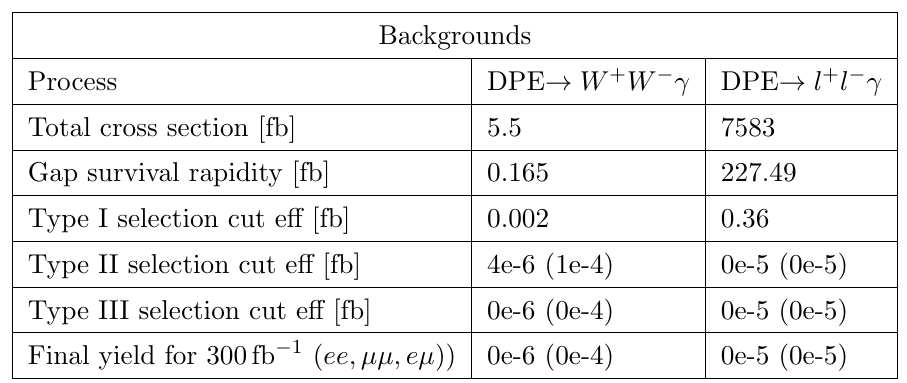
Table 4 . The sequence of di(cid:11)erent type of cuts on the cross sections of DPE ! W + W (cid:0) (cid:13) and DPE ! l + l (cid:0) (cid:13) processes in two signal regions are presented. The last row represents the (cid:12)nal yields for 300 fb (cid:0) 1 IL.